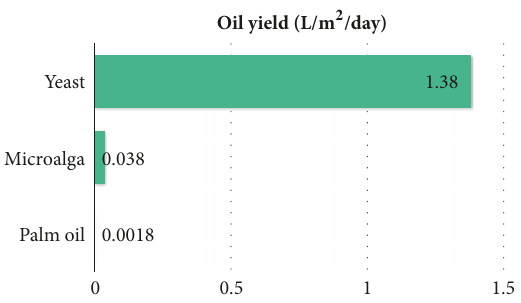
Figure 3: Oil yields per unit of area (m 2 ) per